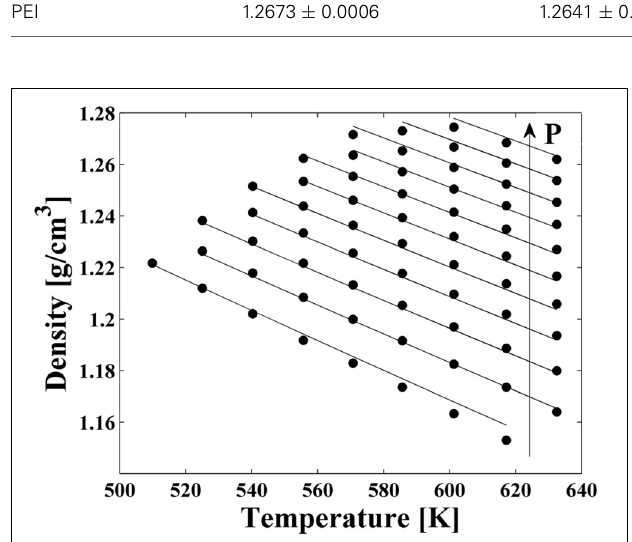
FIGURE 4 | Experimental PVT data for PEI (full circles). Lines represent fitting results by using NRHB